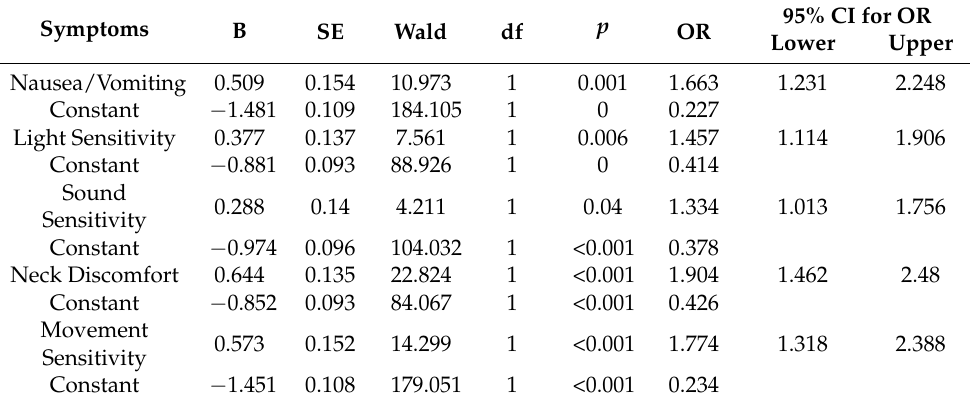
Table 7. Logistic Regression Analysis of Symptoms Associated with Headache Among Health- care